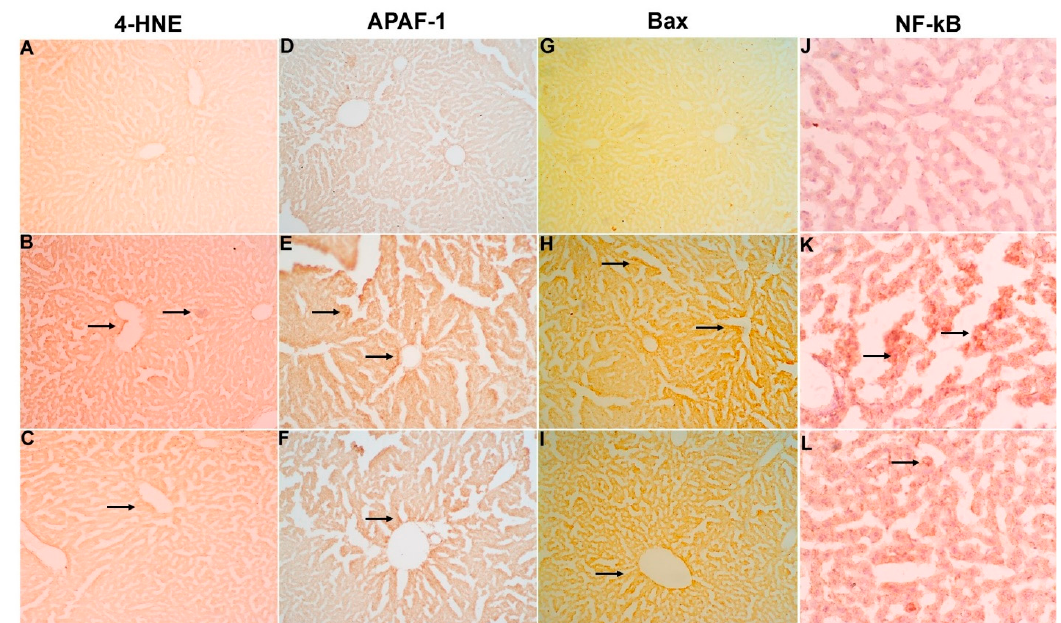
Figure 5. Micrograph representing the protective role of Cur-NLC in relation to LPO marker 4-HNE ( A – C ), apoptotic indices (APAF-1 and Bax, D – I ), and inflammatory marker NF- κ B ( J – L ) by immunos- taining. Elevated expression was observed in the section of the Cyp-treated group ( B , E , H , K ) as compared to the control ( A , D , G , J ), while the Cyp+NC (5 mg)-treated group has shown a suppres- sion in immunostaining of 4-HNE ( C ), APAF-1 ( F ), Bax ( I ), and NF- κ B ( L ). Photomicrographs were obtained by light microscope at 40 × magnification.